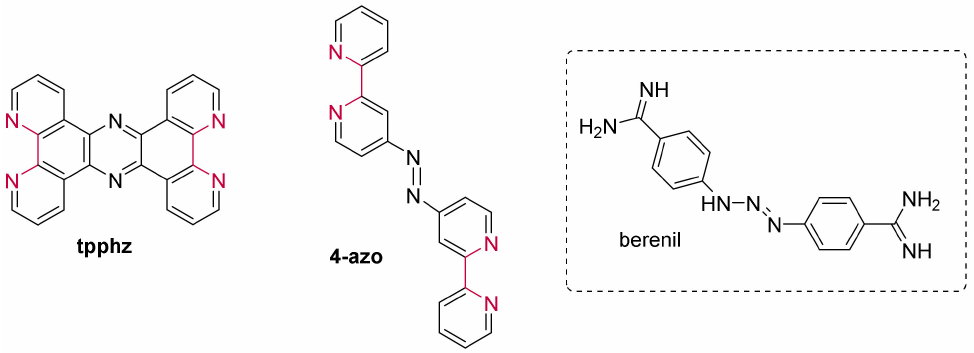
Figure 26. Structure of the tpphz and 4-azo ligands to form the dinuclear ruthenium(II) complexes studied by Thomas et al. in the presence of G-quadruplexes